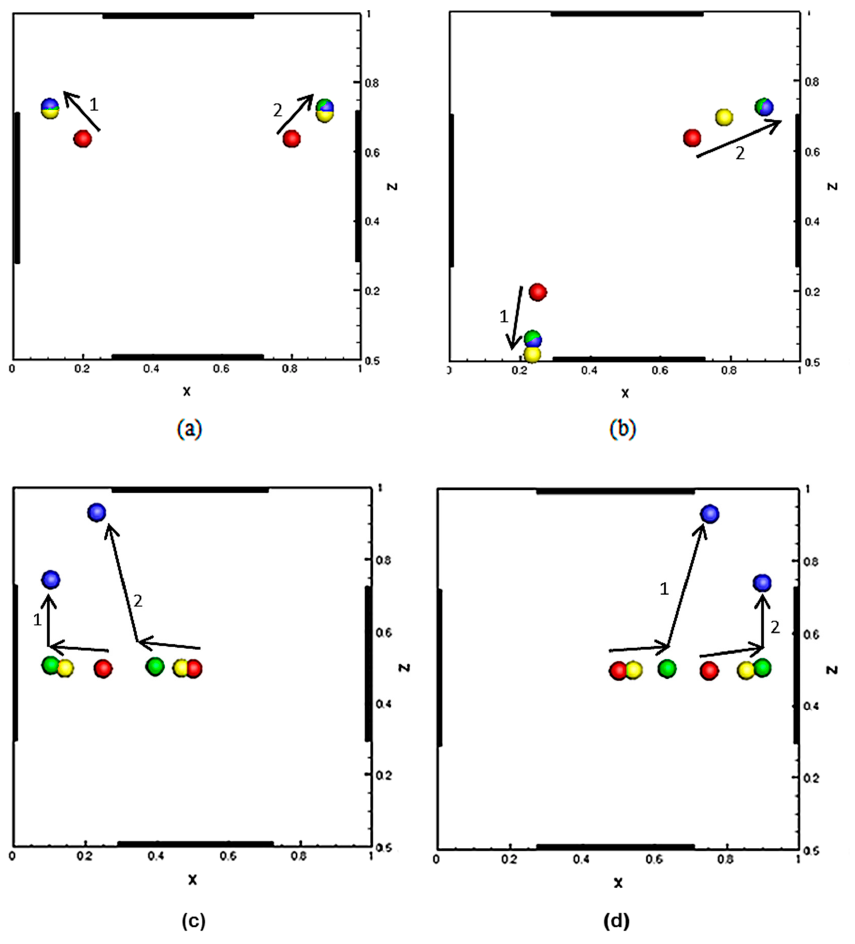
Figure 6. The DEP force-induced motion of two particles in the xz -plane under positive dielectrophoresis. The diameter of particles is 0.2. The initial positions of the two particles, shown by red circles, are: ( a ) (0.2, 0.25, 0.65) and (0.8, 0.25, 0.65); ( b ) (0.25, 0.25, 0.2) and (0.5, 0.25, 0.65); ( c ) (0.25, 0.25, 0.50) and (0.5, 0.25, 0.50); ( d ) (0.75, 0.25, 0.50) and (0.50, 0.25, 0.50). The dimensionless parameters are: Re = 0.652, P E = 74.7, and P 4 = 0.117. Notice that in most cases particles are collected at the electrode edge that is nearest to them.